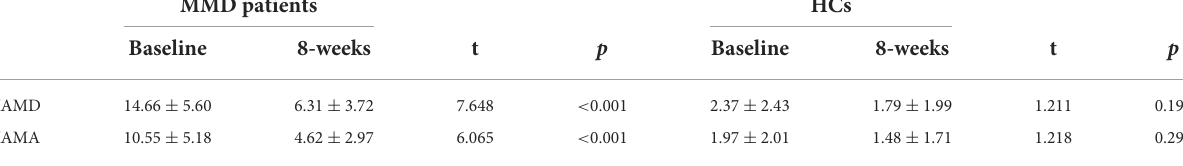
TABLE 2 Comparison of depression variables between patients with MMD after 8 weeks SG-treatment and HCs after 8 weeks (mean ±